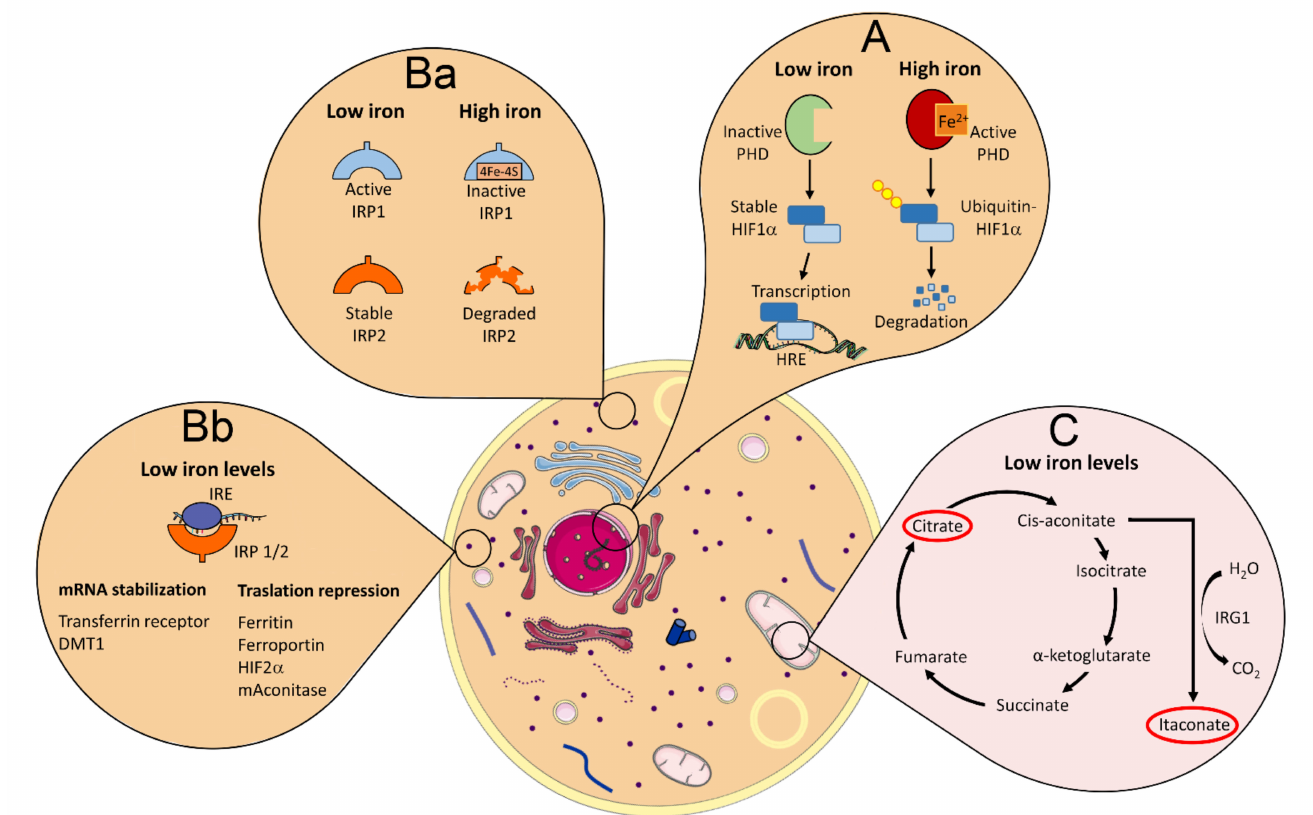
Figure 2. Major iron-regulated pathways involved in the modulation of inflammation and immune responses. ( A ) Prolyl hydroxylase (PHD) enzymes use iron as a cofactor to mediate the reaction that results in the ubiquitination and further degradation of HIF-1 α by the proteasome in high iron concentration environment. In the presence of low iron levels, PHDs are inactivated, which results in the stabilization of HIF-1 α molecules that migrate to the nucleus and promote the transcription of pro-inflammatory genes. ( Ba ) Iron regulatory proteins 1 and 2 (IRP1 and 2) are active (IRP1) or stabilized (IRP2) in low iron concentration or are inactivated (IRP1) or degraded (IRP2) in high iron concentrations. ( Bb ) Active and stable IRPs (low iron levels) bind to iron responsive element (IRE) motifs present in the untranslated region (UTR) of mRNA molecules of some proteins, which can stabilize mRNA and promote protein translation if the IRE is located at 3 (cid:48) of the mRNA UTR (transferrin receptor and DMT1), or induce translation repression if the IRE is located at 5 (cid:48) of the mRNA UTR (ferritin, ferroportin, HIF-2 α , and mitochondrial aconitase)—high iron levels inactivate or degrade IRPs and the opposite effect is observed regarding the translation of these proteins’ mRNA molecules. ( C ) Low iron levels result in reduced translation of mitochondrial aconitase, which breaks the TCA (tricarboxylic acid) and promotes the accumulation of citrate and itaconate (highlighted with a red circle), which mediate lipid synthesis and anti-inflammatory effects, respectively. Some elements in this figure use pictures from Servier Medical Art (https://smart.servier.com, last